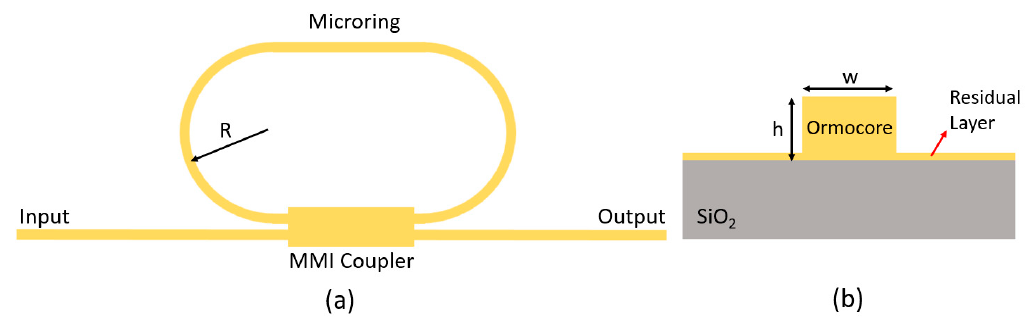
Figure 1. ( a ) The schematic configuration of microring resonator with multimode interference (MMI) coupler; ( b ) The cross-section of the polymer-based ridge waveguide.